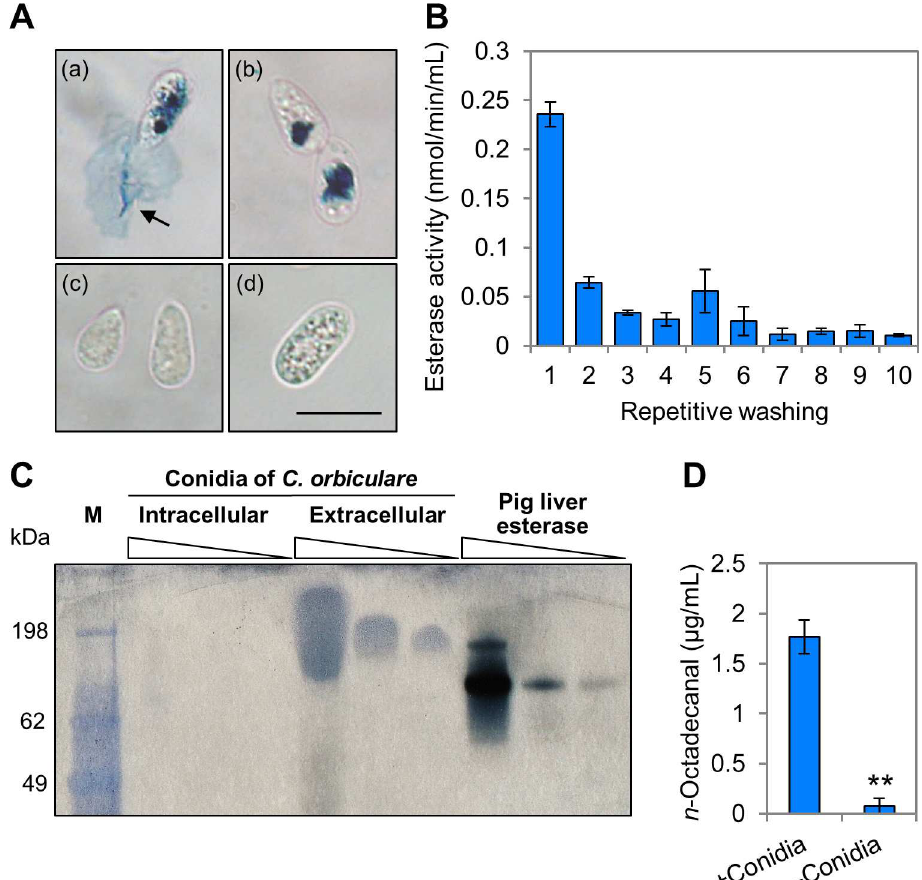
Fig 5. Extracellular esterasesfrom the surfaceof C . orbiculare conidia hydrolyze the host plant cuticle. (A) Histochemical demonstration of surface-localizedesterase activity using indoxyl acetate as a substrate. (a) Unwashed conidiawere moved from the adhesion surface and underlyingindigoblue crystals were exposed(arrow). (b) No crystals appearedon the adhesionsurface of washedconidia.(c) Autoclaved conidiahad no indigoblue crystals. (d) Unwashed native conidiumon medium without indoxylacetate. Scale bar, 10 μ m. (B) Mean activity ( ± SE) of esterase released from surface of conidiaby repetitive washing.Activity in conidialwashing supernatantswas evaluatedwith p -nitrophenyl butyrate as the substrate. Values are means of three replications. (C) Conidialsurface esterases of C . orbiculare in native polyacrylamide gel after electrophoresis. Intracellular, protein preparations isolatedfrom washedconidia;extracellular, protein preparations washedfrom conidia;pig liver esterase, a positive control of hydrolysis; M, molecularweight marker. Amount of protein loadedwas (left to right) 1.0, 0.1 and 0.05 μ g. (D) Quantity of n -octadecanal in cucumber exudate(means ± SE; n = 3). n -Octadecanal was detected in the exudate collectedwith conidial suspension (+conidia), but not in the exudatecollected with distilledwater (-conidia).Asterisk representsa significantdifference (Student’s t- test; ** P <